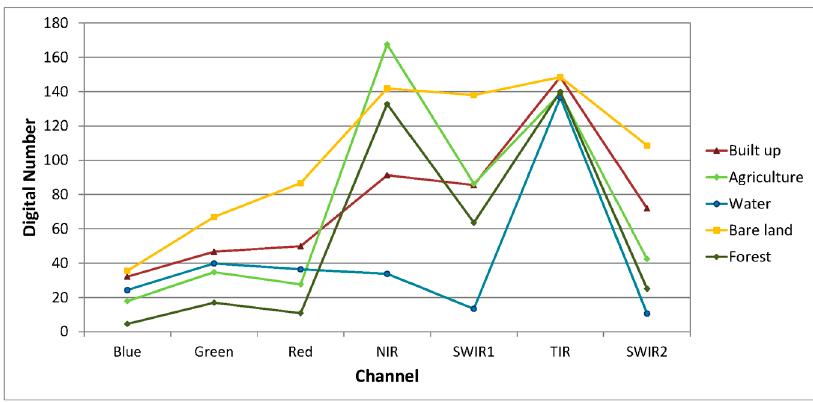
Figure 3. Spectral profiles of five classes in the study site. All values are stretched into [0,